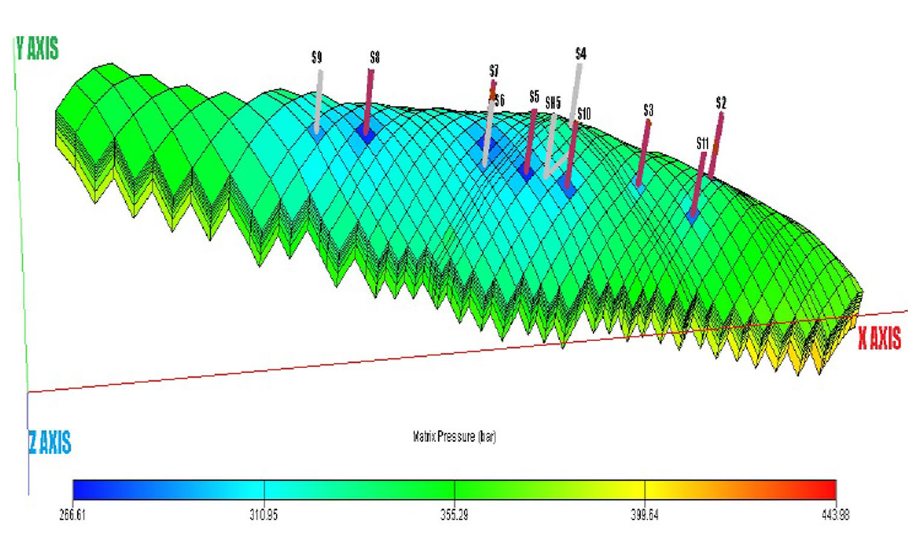
Fig. 1 Static model of the field along with the location of exist- ing